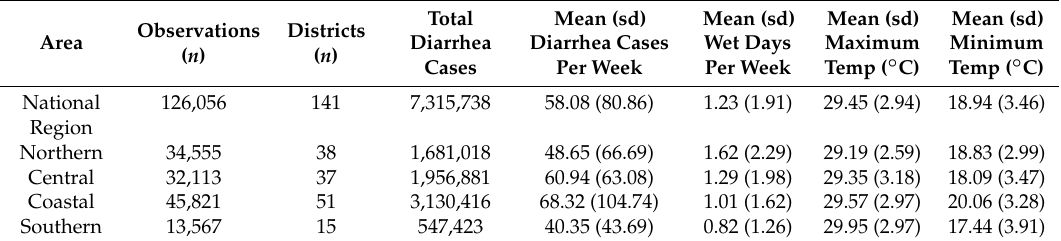
reported over the study